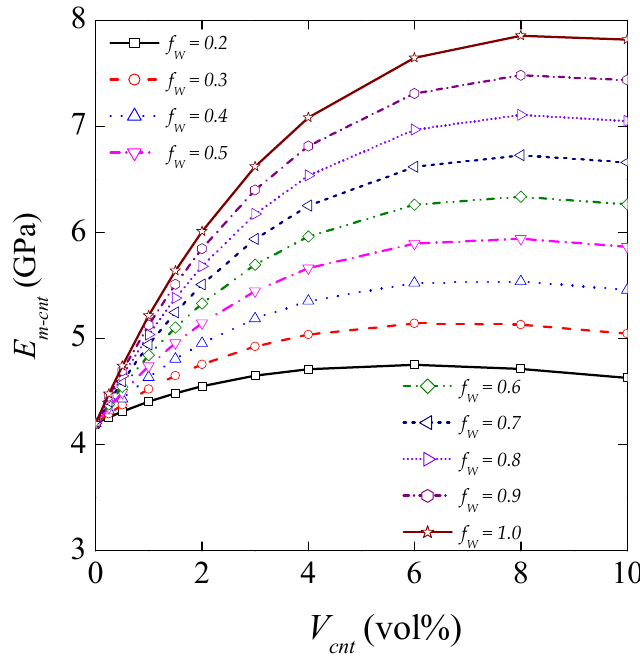
Figure 7. Young’s modulus of CNT ‐ reinforced matrix as a function of V cnt (vol%) for various f w waviness factors. The diagram shows the effect of waviness factors on Young’s modulus (GPa) by chang ‐